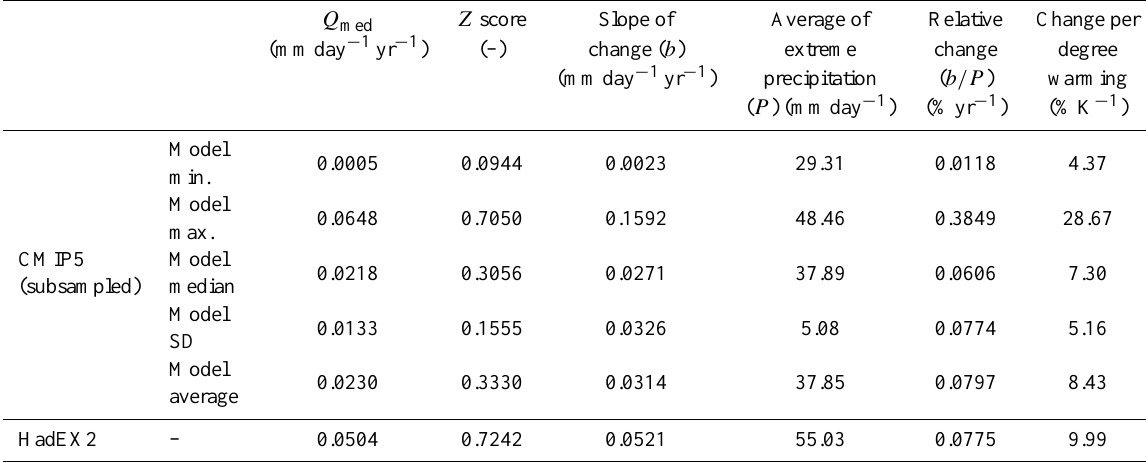
Table 1. Statistics of variation of global average extreme precipitation for HadEX2 and the 19 subsampled CMIP5 model runs from 1901 to 2010. The 19 climate model runs give 19 global averages, of which the minimum, maximum, median, mean, and standard deviation are presented. Q med Z score Slope